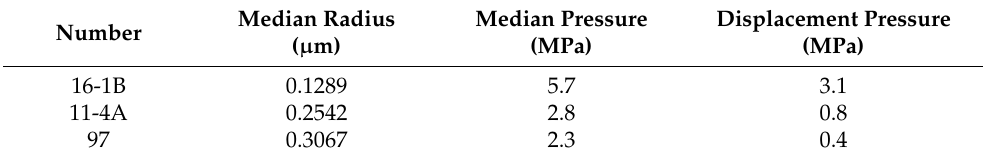
Table 5. HPMI results for the three